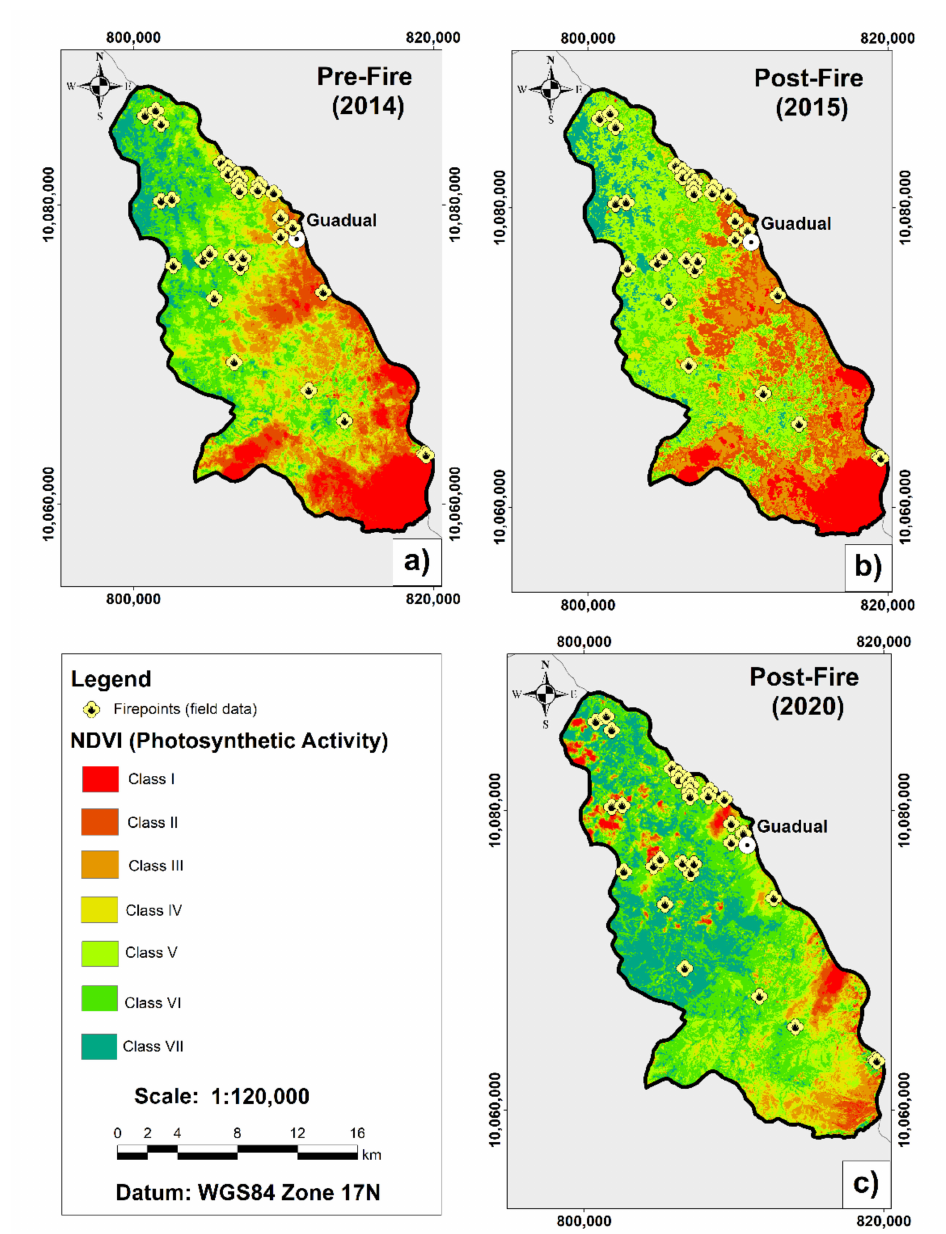
Figure 5. NDVI results: ( a ) NDVI pre-fire 2014, ( b ) NDVI post-fire 2015 and ( c ) NDVI post-fire 2020, calculated with